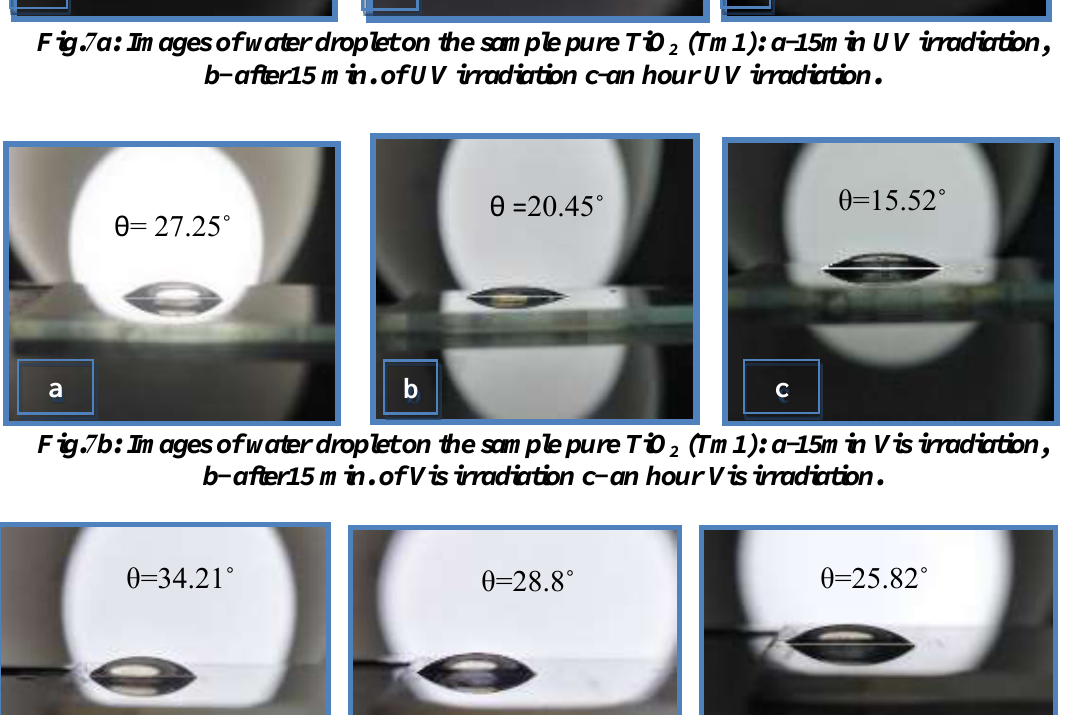
Fig.8a: Images of water droplet on the sample pure TiO b- after 15 min. of UV irradiation c -an hour UV irradiation